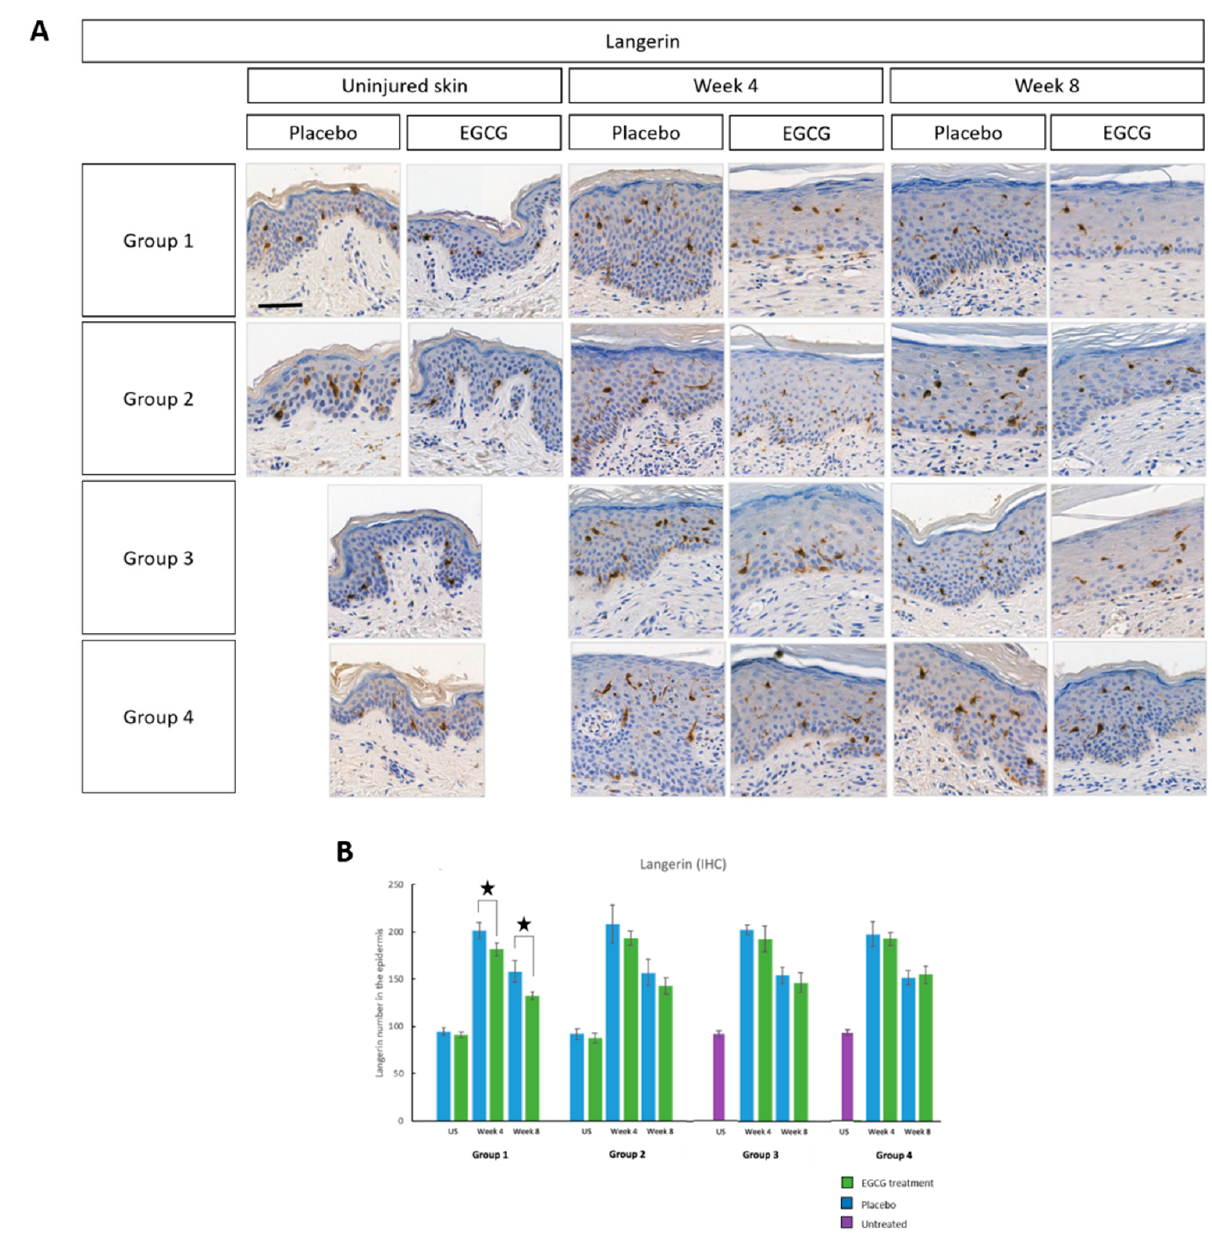
Figure 8. Immune cell marker analysis of topical epigallocatechin-3-gallate (EGCG) versus placebo (Langerin). ( A ) Langerin immunohistochemical images showed reduced expression in EGCG samples compared to placebo samples. Scale bars = 20 µ m. ( B ) Analysis of the total number of cells in the whole epidermis demonstrated a significant reduction in EGCG-treated samples compared to placebo samples at week 4 in Group 1 only ( p = 0.02). No differences were observed between the groups. Significance: (cid:70) p < 0.05 Scale bars = 50 µ